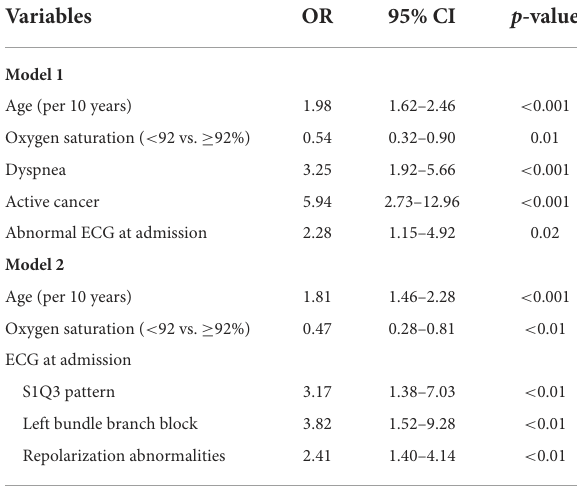
TABLE 2 ECG characteristics at admission in patients presenting with COVID-19.